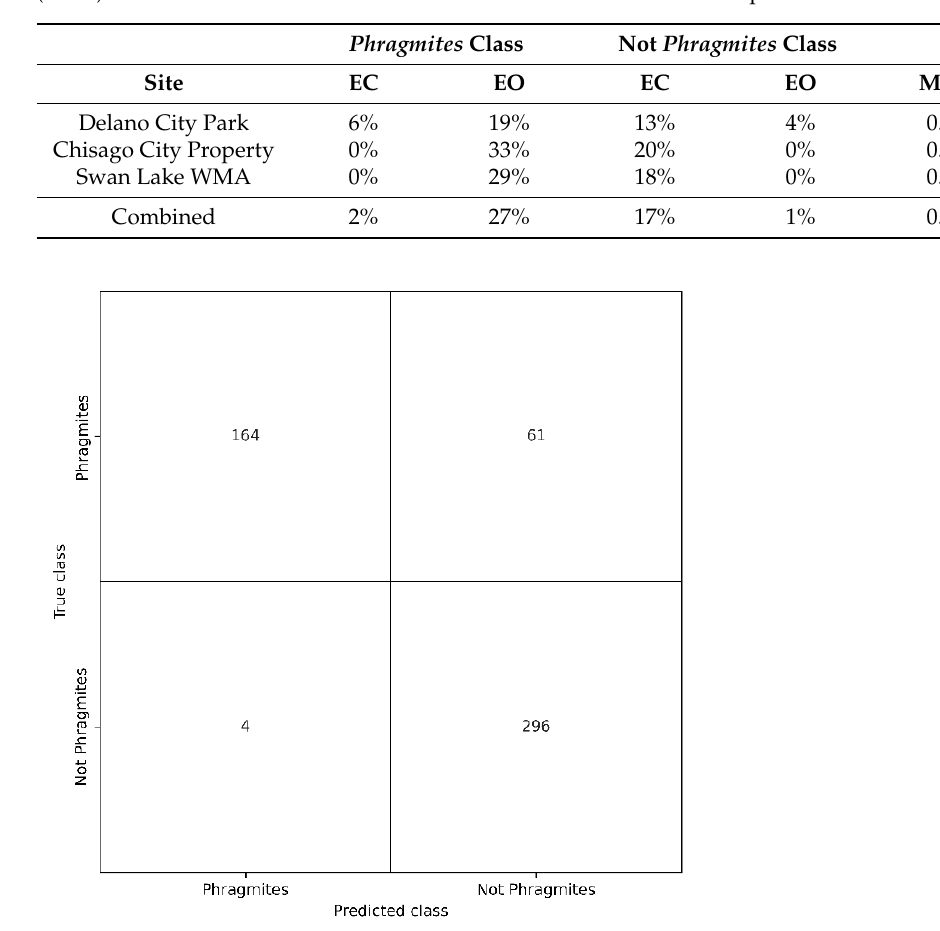
Table 12. Validation assessment points for each of the three validation sites for the artificial neural network classification with the post-ML OBIA rule set.